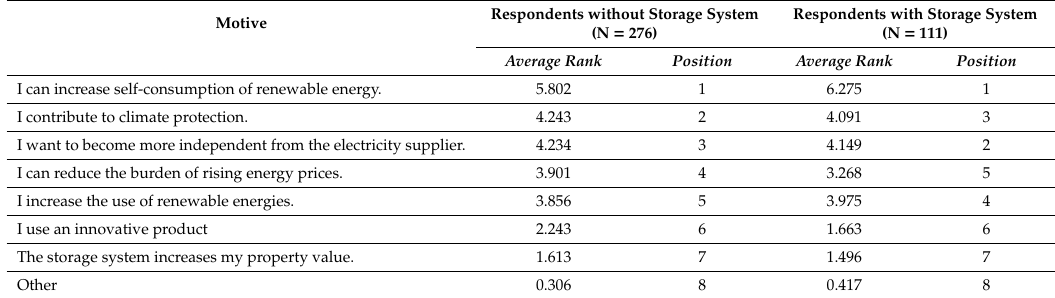
Table 2. Ranking of motives for storage